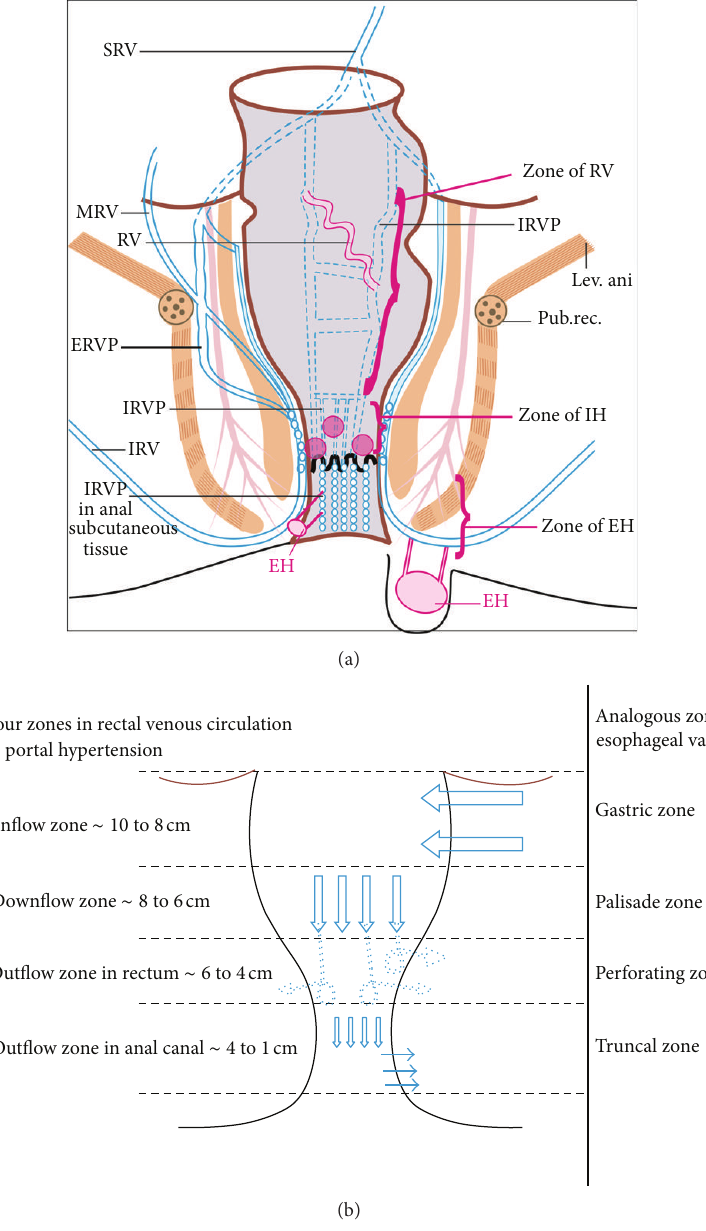
Figure 1: (a) The superior rectal vein (SRV) divides into two branches, which enter the lateral wall of rectum, about 10cm above the dentate line. The middle and inferior rectal veins (MRV & IRV), empty into the caval system. The rectal veins form two plexuses, an internal one lying in the submucosa and the corresponding anal “Subcutaneous” tissue and an external one lying outside the muscular wall of the bowel below the level of the peritoneal reflection. The intrinsic rectal venous plexus consists of two groups of veins draining in opposite direction. The inferior group passes down to form the inferior rectal veins, and dilation of this group leads to formation of external hemorrhoids. The vessels of the superior group in the anal columns lead to the formation of internal hemorrhoids and in the rectum lead to the formation of rectal varices. (b) Four distinct zones of mucosal circulation are seen in rectum with similarity to esophageal circulation. The inflow area is analogous to the gastric zone, the downflow area is analogous to the palisade zone, the outflow area in rectum is analogous to the perforating zone, and the outflow area in anal canal is analogous to the truncal zone of esophageal